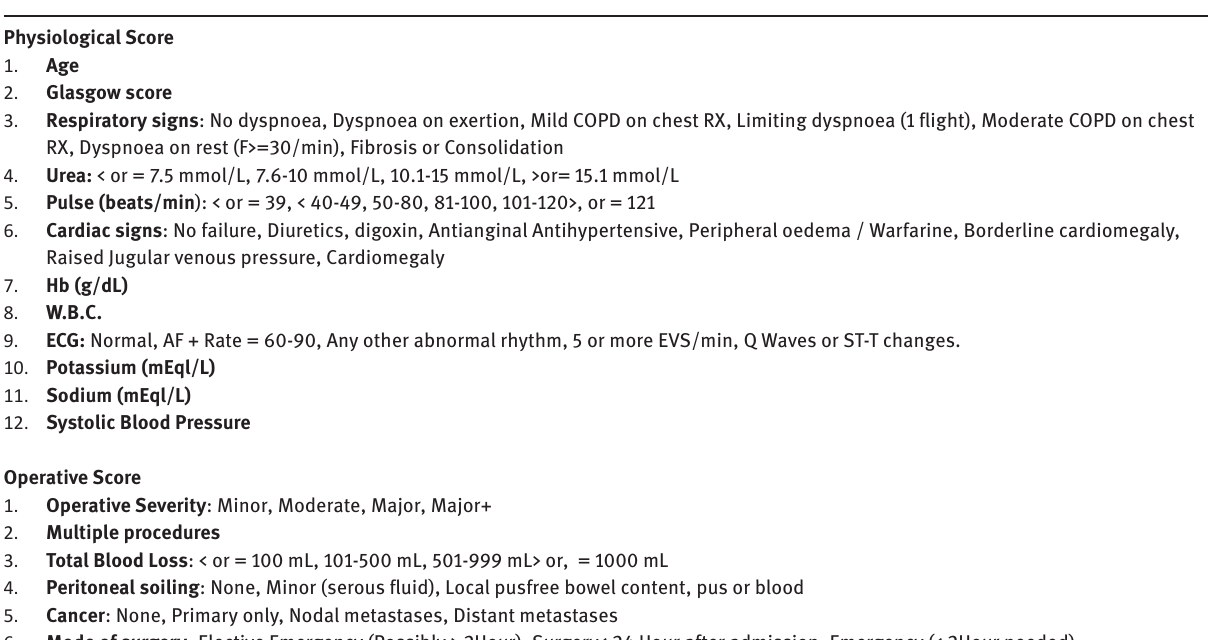
Table 1 : The POSSUM system [8] takes into account the operative severity as well as patient’s physiological characteristics by scoring 12 physiological parameters and 6 operative details when assessing